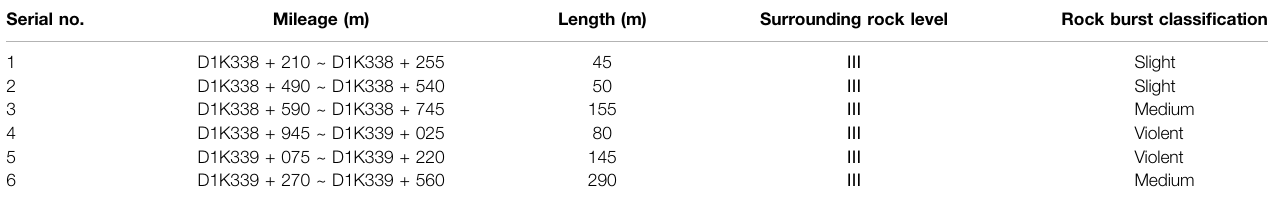
TABLE 6 | List of large deformation sections of rock burst in the main tunnel. Serial